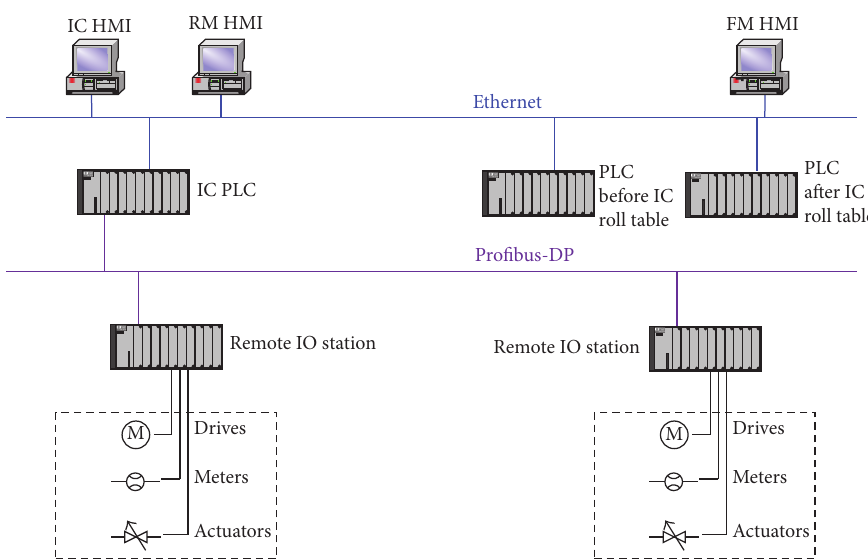
Figure 4: Block diagram of adaptive control